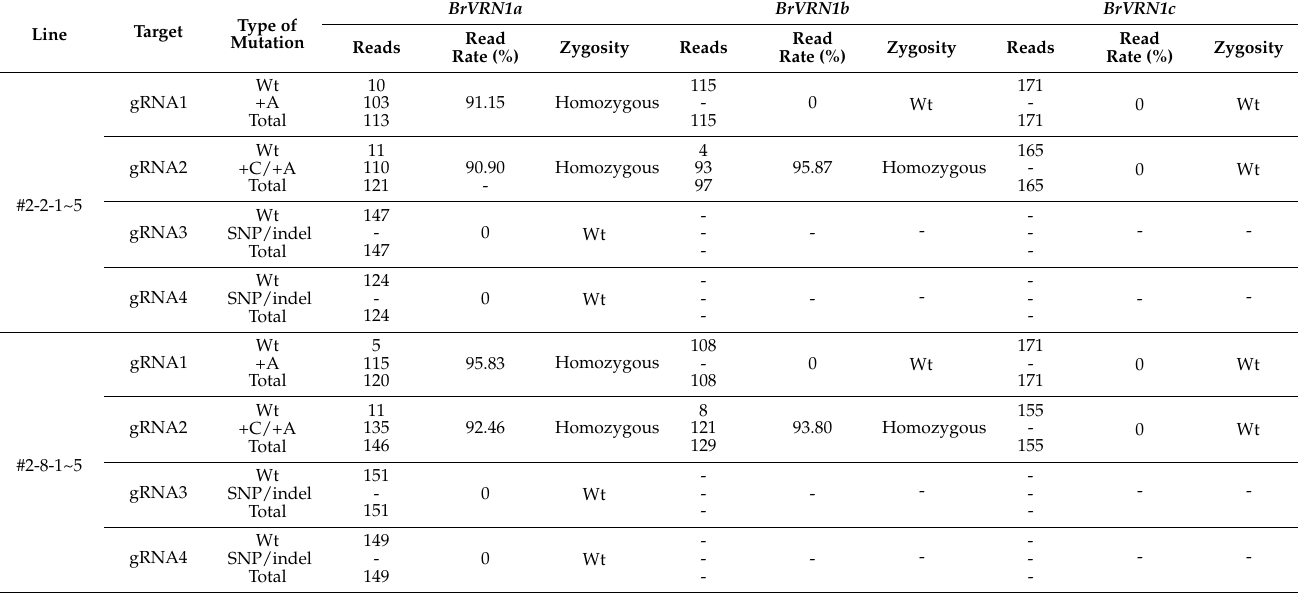
* 1 No. of Total trimmed reads: Total number of clean reads used for read alignment through pre-processing. * 2 No. of Mapped reads: When clean reads are aligned, the number of reads mapped to the vector sequence. * 3 Mapped region: Compared to the vector 13,301 bp sequence, the base pair of the region covered by read alignment. Table 5. Summary of zygosity and genotype of BrVRN1 mutations in the ‘transgene-free’ GE2 mutant